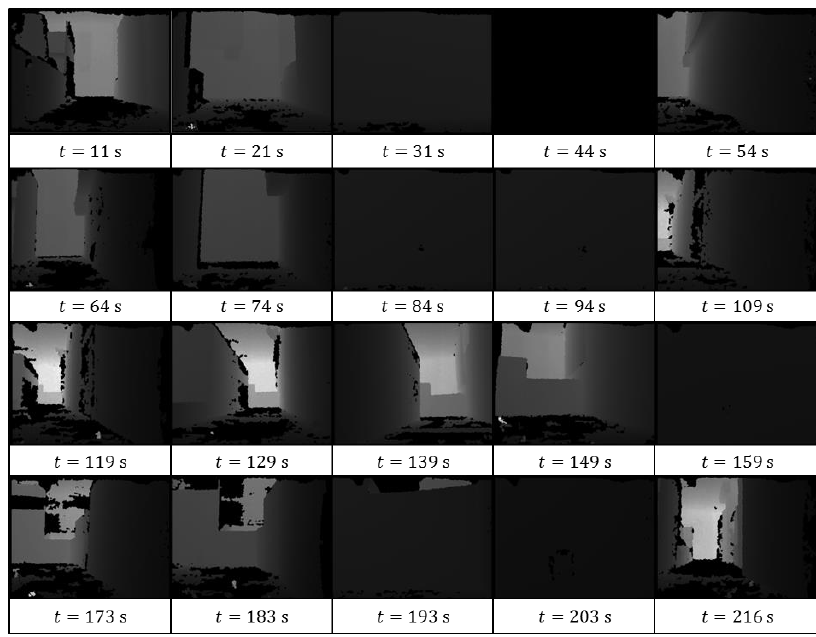
Figure 11. Depth information recorded from SVS during the patrol task.